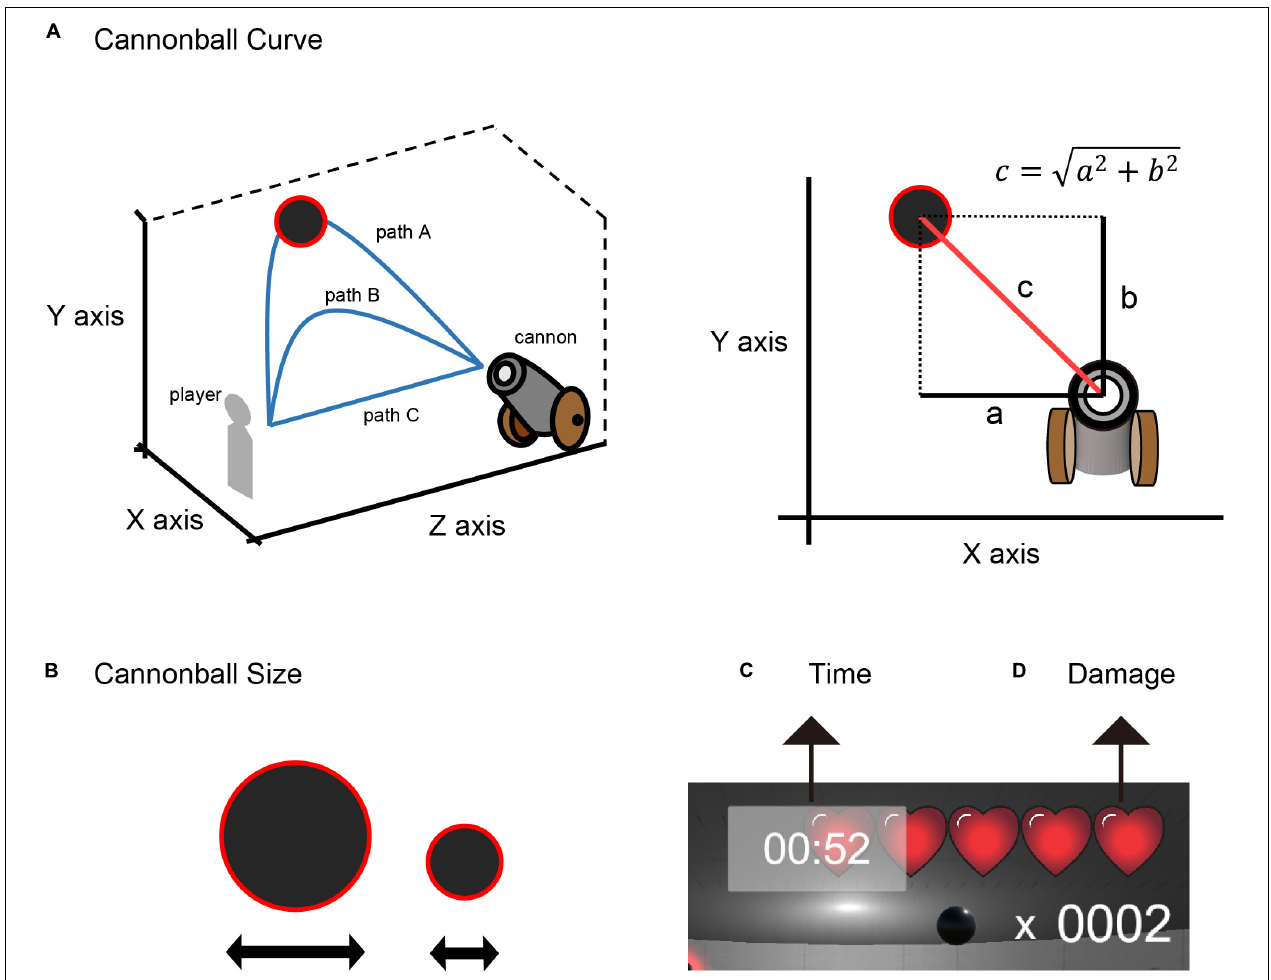
FIGURE 4 | Experimental features. (A) cannonball curve, (B) cannonball size, (C) time, and (D)